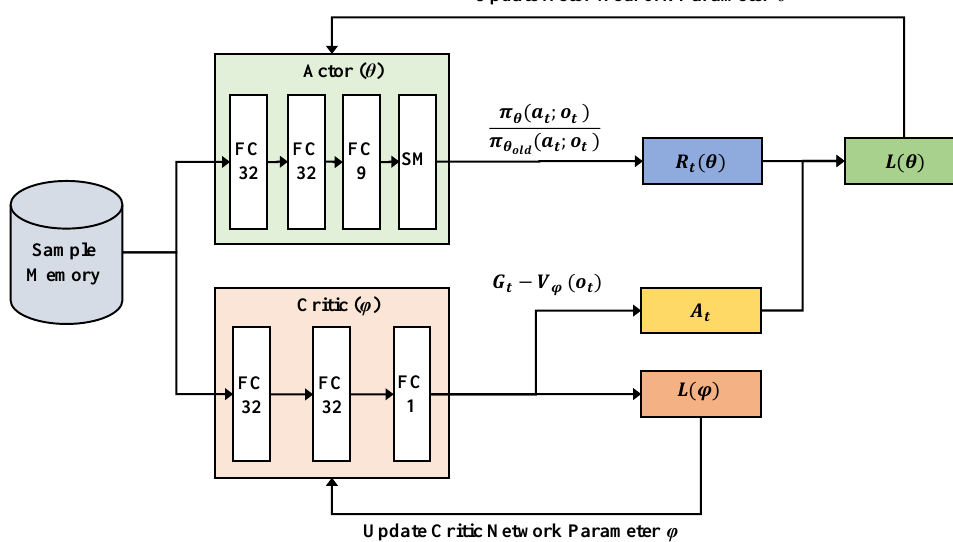
Figure 5. Actor-critic based PPO. The actor and critic networks are trained to complement each